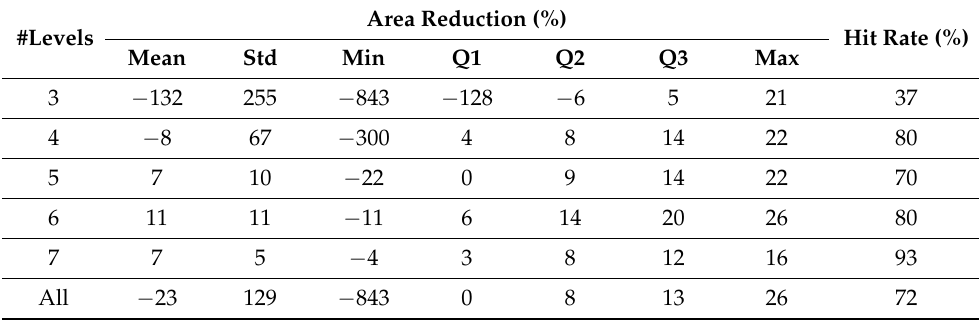
Table 3. Area reduction of CARRY-MAP with respect to VIV-MAP in speed optimization.